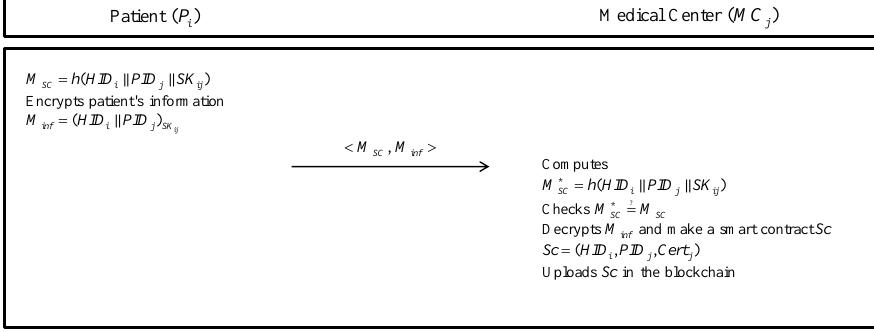
Figure 5. Smart contract uploading phase of the proposed protocol.